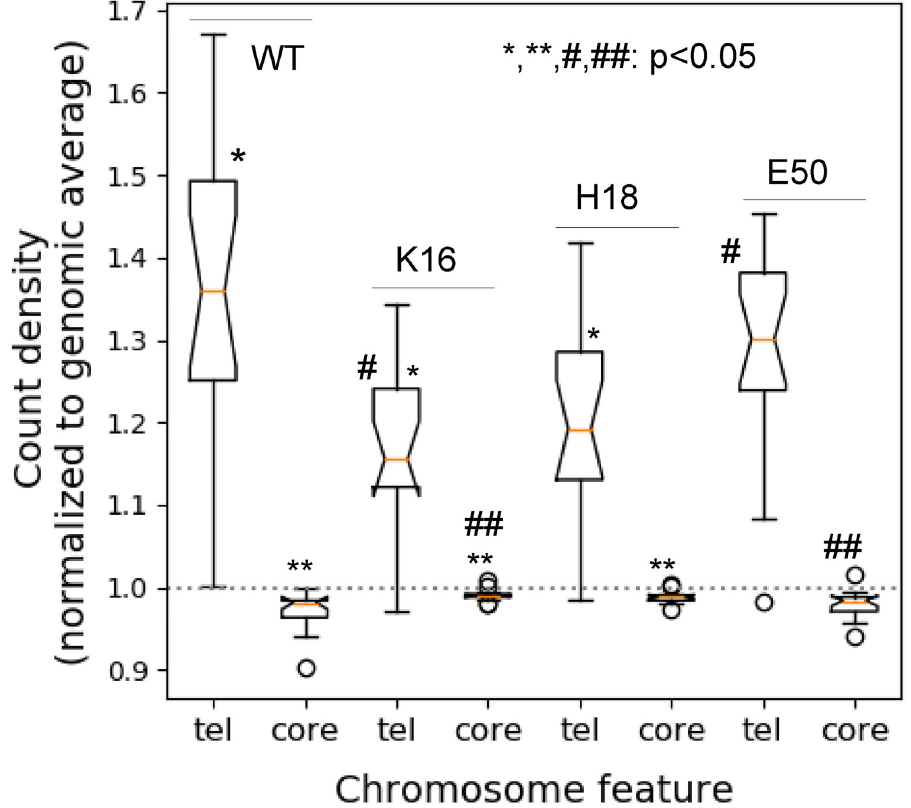
Fig 4. Distribution of Sir3 between telomeres and chromosome cores. The level of Sir 3 associated with the 20kb chromosome termini and the internal core regions excluding the 20 kb termini were determined from the ChIP-seq signal for each of the 16 chromosomes, and normalised to the genome average. The values are shown for the WT and H4K16Q, H4H18A and H3E50A mutant strains. The box plots represent the inter-quartile range (IQR), the notch represents the significance at p < 0.05, the orange line shows the median, and the whiskers is shown at 1.5 × the IQR. Outliers are shown as individual data points. WT and mutants strains and mutant-mutant strain pairs that are significantly different ( t -test; p < 0.05) in the telomeric and core regions are indicated by the � and # and by �� and ## symbol pairs,